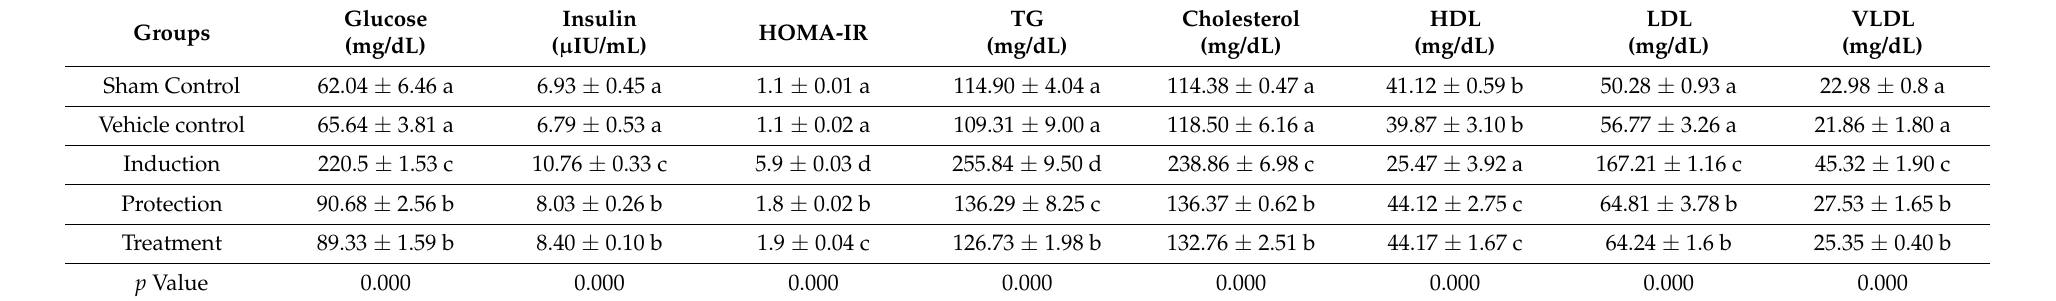
Table 4. Effect of different treatments on the serum diabetic